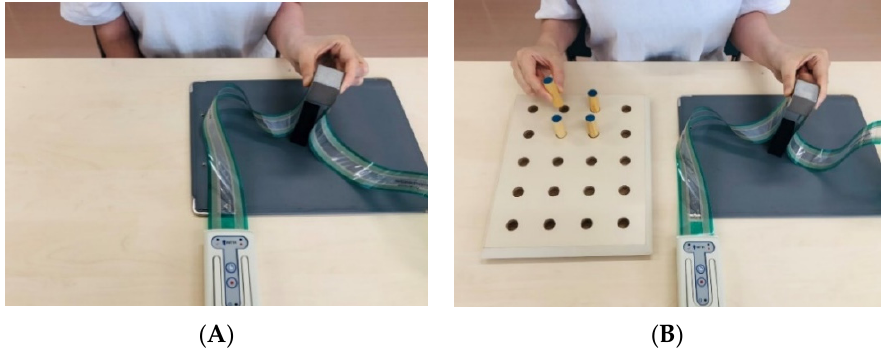
Figure 1. Grip-lifting task: ( A ) Single task; ( B ) Dual task.